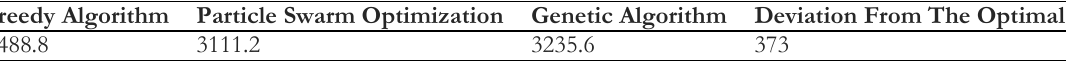
Table 3. Total cost of the